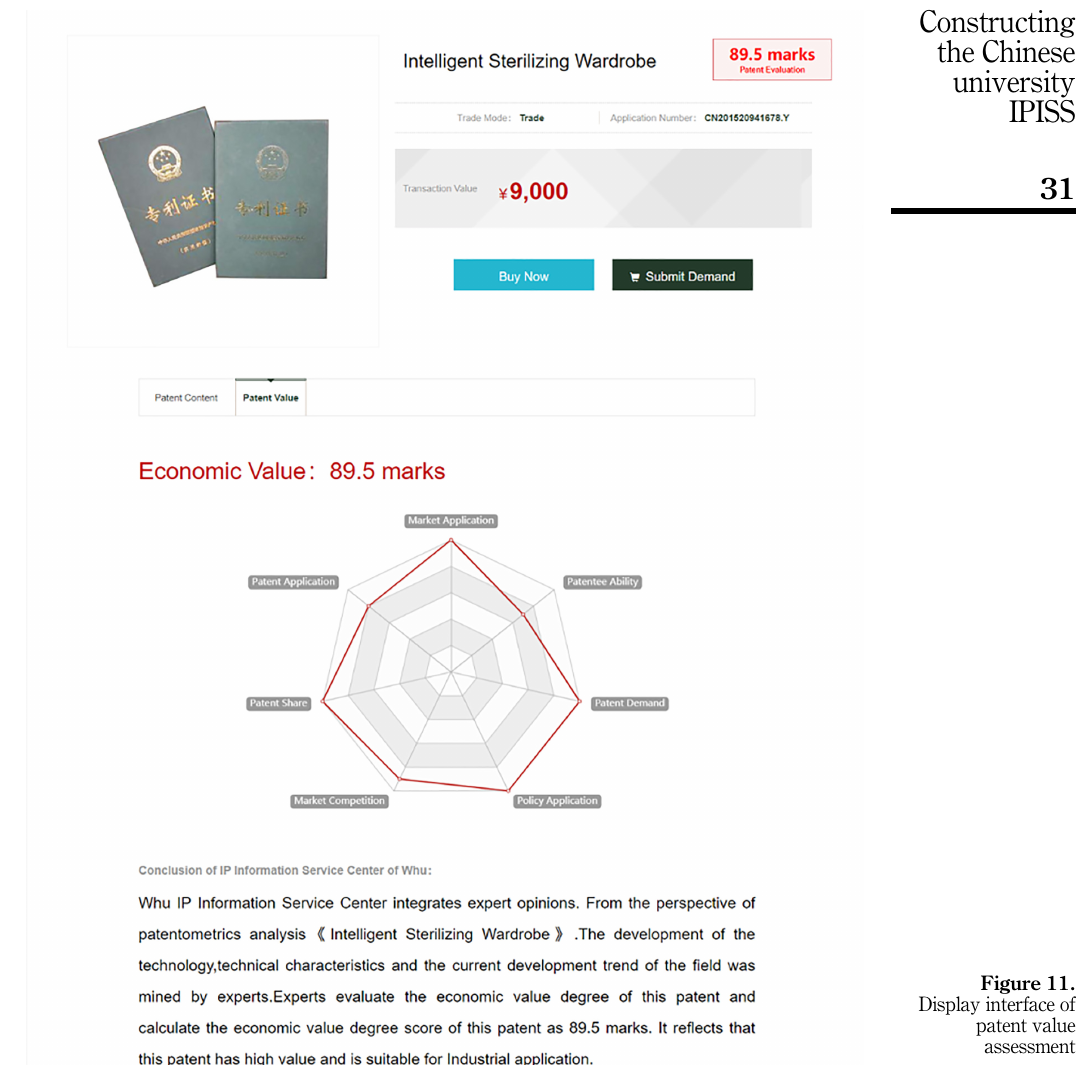
Figure 11. Display interface